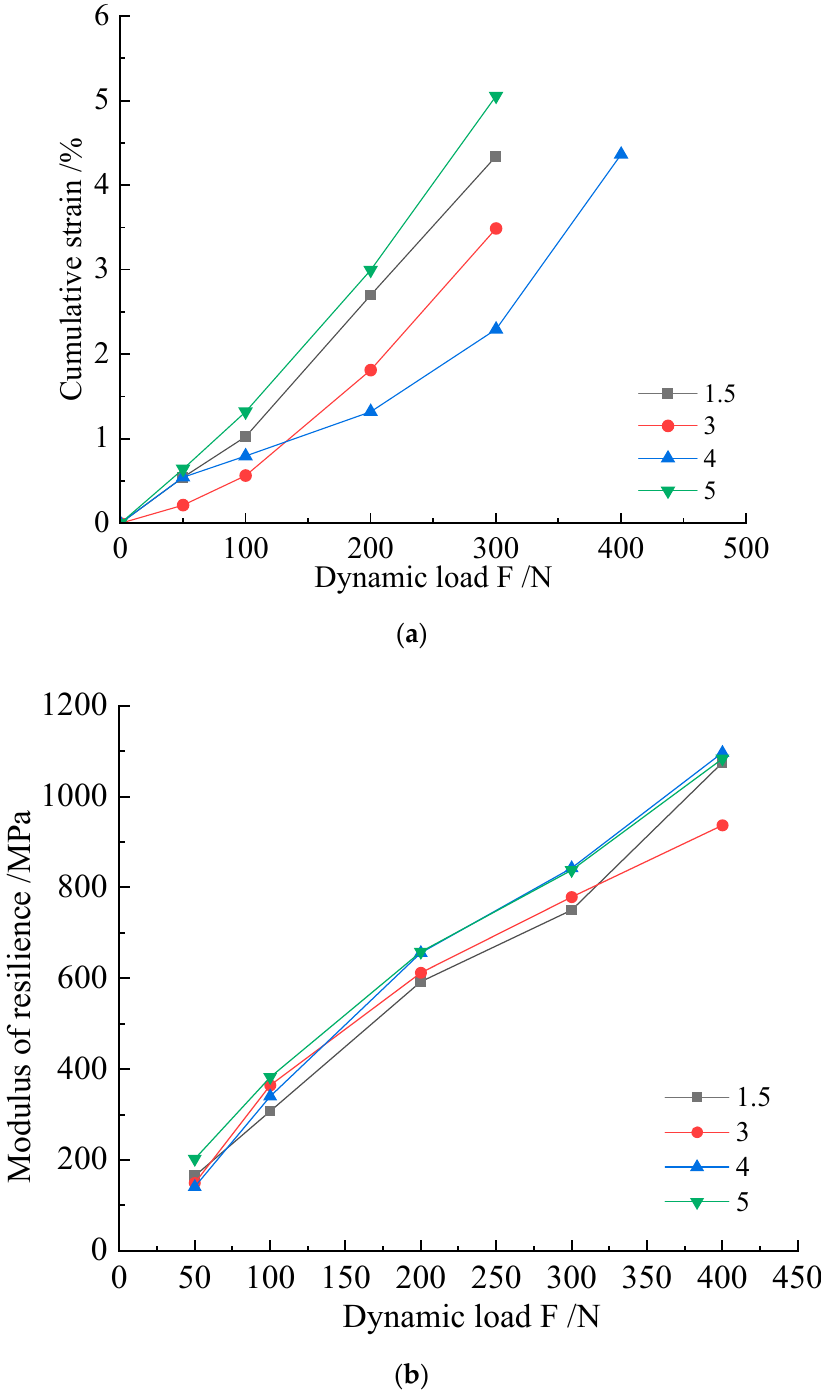
Figure 9. ( a ) Cumulative strain curves of M-L scheme specimens. ( b ) Resilience modulus (Ed) versus dynamic load curve.